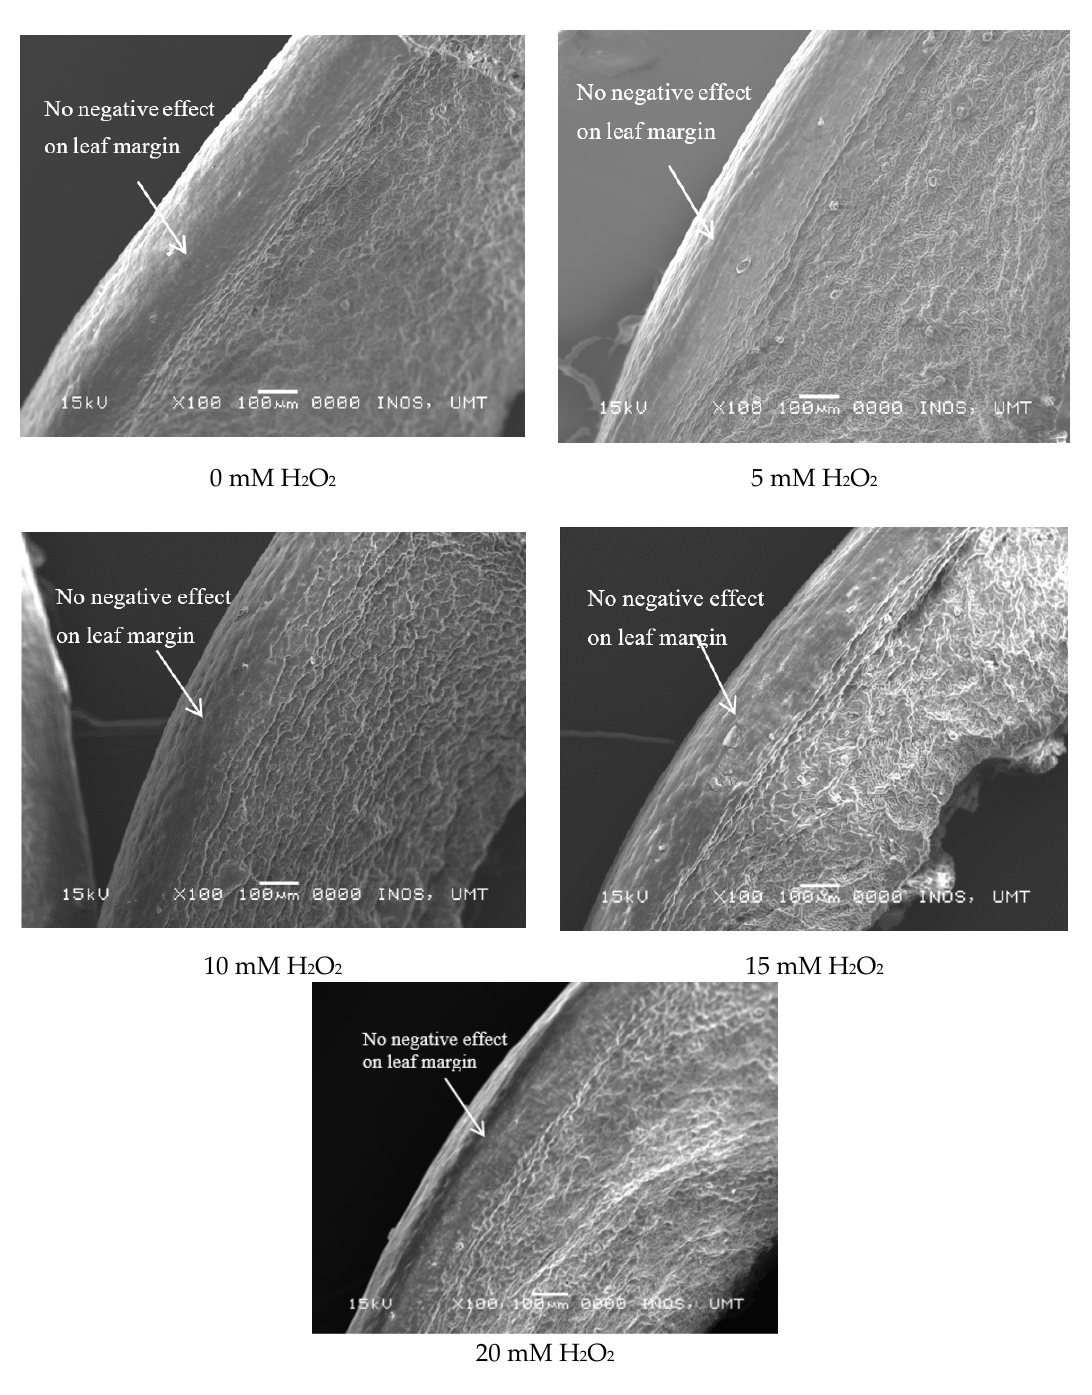
Figure 4. SEM photographs show that no damage was caused by H 2 O 2 direct application via spraying on the leaves of Ficus deltoidea var. deltoidea plant.